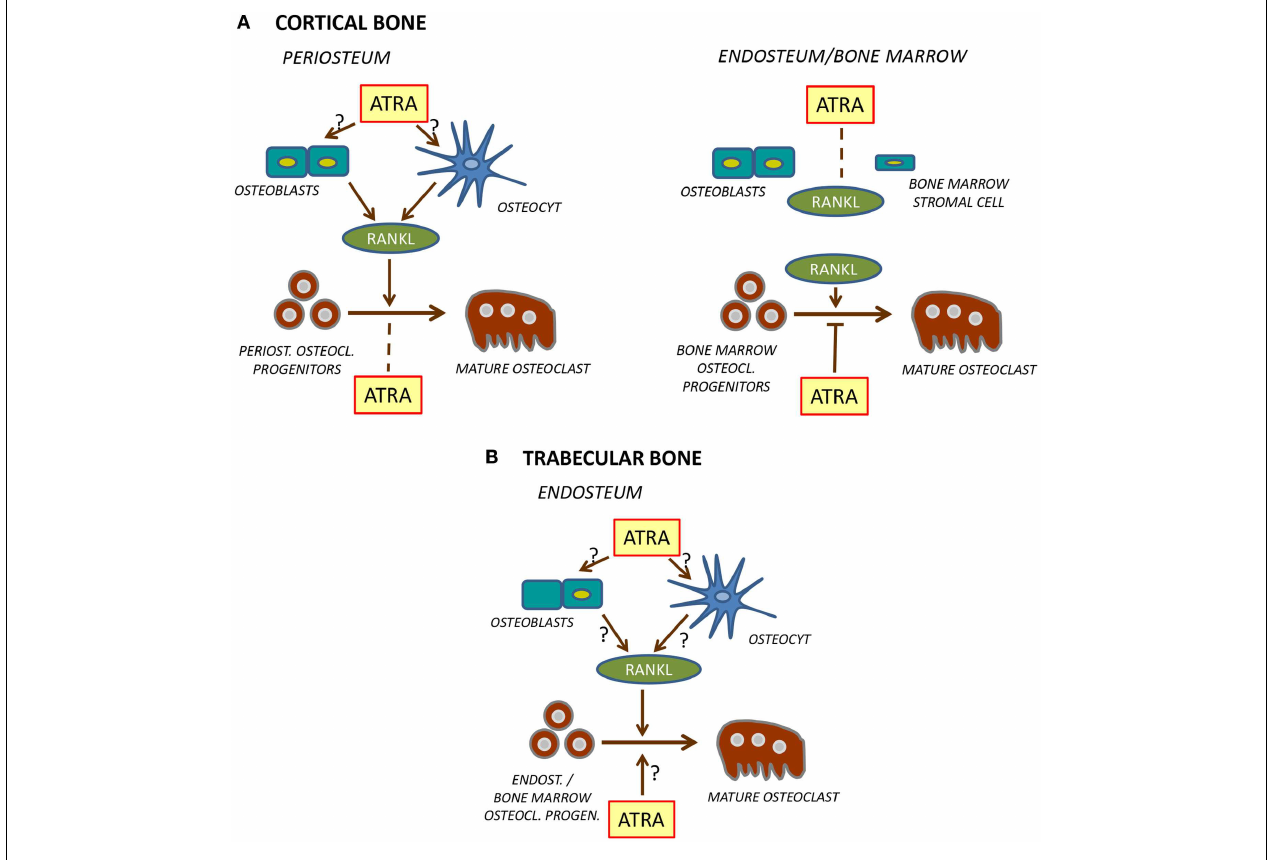
these osteoclast progenitors. In bone marrow or at endosteal site [ (A) , right ], ATRA does not stimulate RANKL formation but inhibits differentiation of osteoclast progenitors to mature osteoclasts.The role of ATRA for osteoclast formation on the endosteal surfaces of trabecular bone (B) is currently not